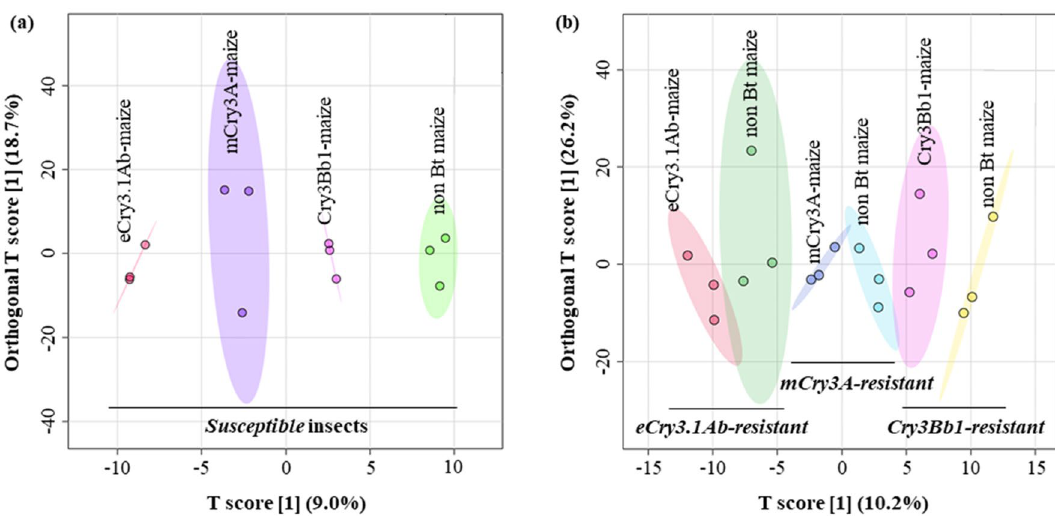
Figure 1. Differences in metabolic profiles of WCR susceptible ( a ) and resistant insects ( b ) fed on control non-Bt maize compared with those fed on eCry3.1Ab-, mCry3A-, or Cry3Bb1-expressing maize seedlings using the orthogonal partial least squares—discriminant analysis (OPLS-DA). In the OPLS-DA plot, circles with same colors represent replicates of metabolic profiles for each treatment. The colored ellipses indicate 95% confidence regions of metabolic profiles for each treatment. In ( a ), from left to right, the circles display susceptible insects fed on eCry3.1Ab-, mCry3A-, Cry3Bb1-expressing maize and non-Bt maize, respectively. In ( b ), from left to right, the circles represent eCry3.1Ab resistant insects fed on eCry3.1Ab-expressing maize and non-Bt maize, mCry3A-resistant insects fed on mCry3A-expressing maize and non-Bt maize, Cry3Bb1-resistant insects fed on Cry3Bb1-expressing maize and non-Bt maize, squares—discriminant analysis (OPLS-DA) was performed. In the OPLS-DA plot, the profiles of the susceptible insects were distributed separately along the T score [1] component but shared a similar pattern regarding the orthogonal T score [1] component (Fig. 1a). To further identify those metabolites associated with the differences in the OPLS-DA plot, pattern hunter analysis was conducted to identify metabolites that upregulated or downregulated in the susceptible insects when